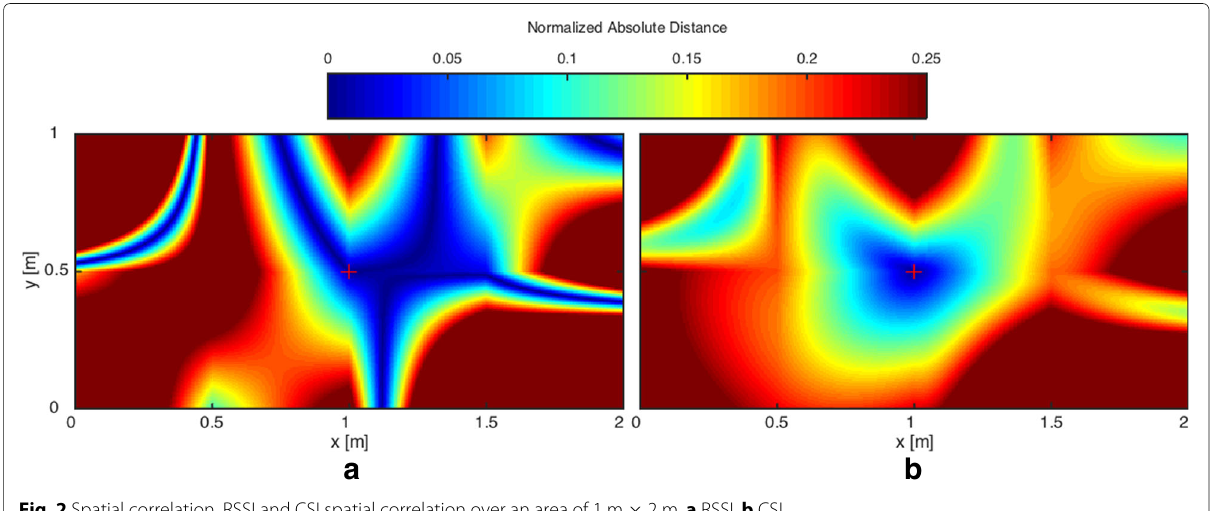
a b Fig. 2 Spatial correlation. RSSI and CSI spatial correlation over an area of 1 m × 2 m. a RSSI. b CSI